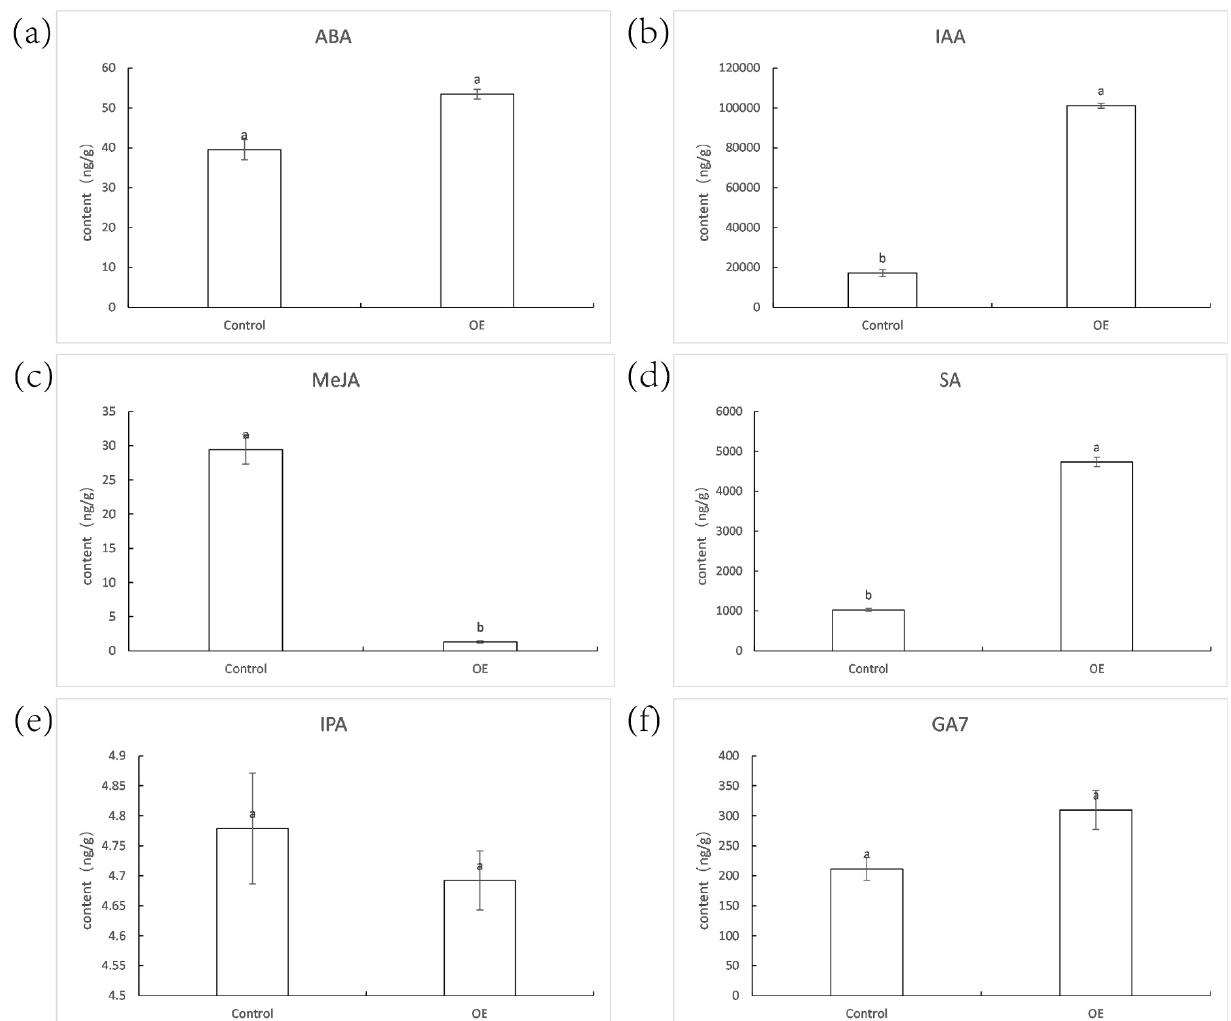
Figure 12. The contents of the plant hormones ABA ( a ), IAA ( b ), MeJA ( c ), SA ( d ), IPA ( e ), and GA 7 ( f ) were determined. Significant differences ( p < 0.05, n = 3) are shown by different letters above the columns.